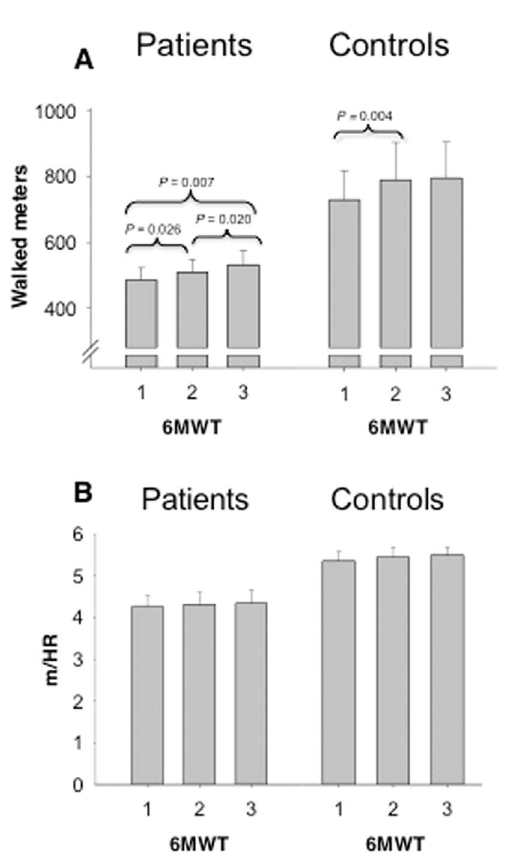
Figure 1. Distance walked with, and without heart rate correction. A. Mean distance walked in all 6- minute walk tests, for both patients and controls. The graph shows the significant increases, marked by the p - value, in mean walked distance among tests. B. Heart rate corrected 6-minute walk distance in all 6-minute walk tests, for both patients and controls. No significant difference between walked distances was